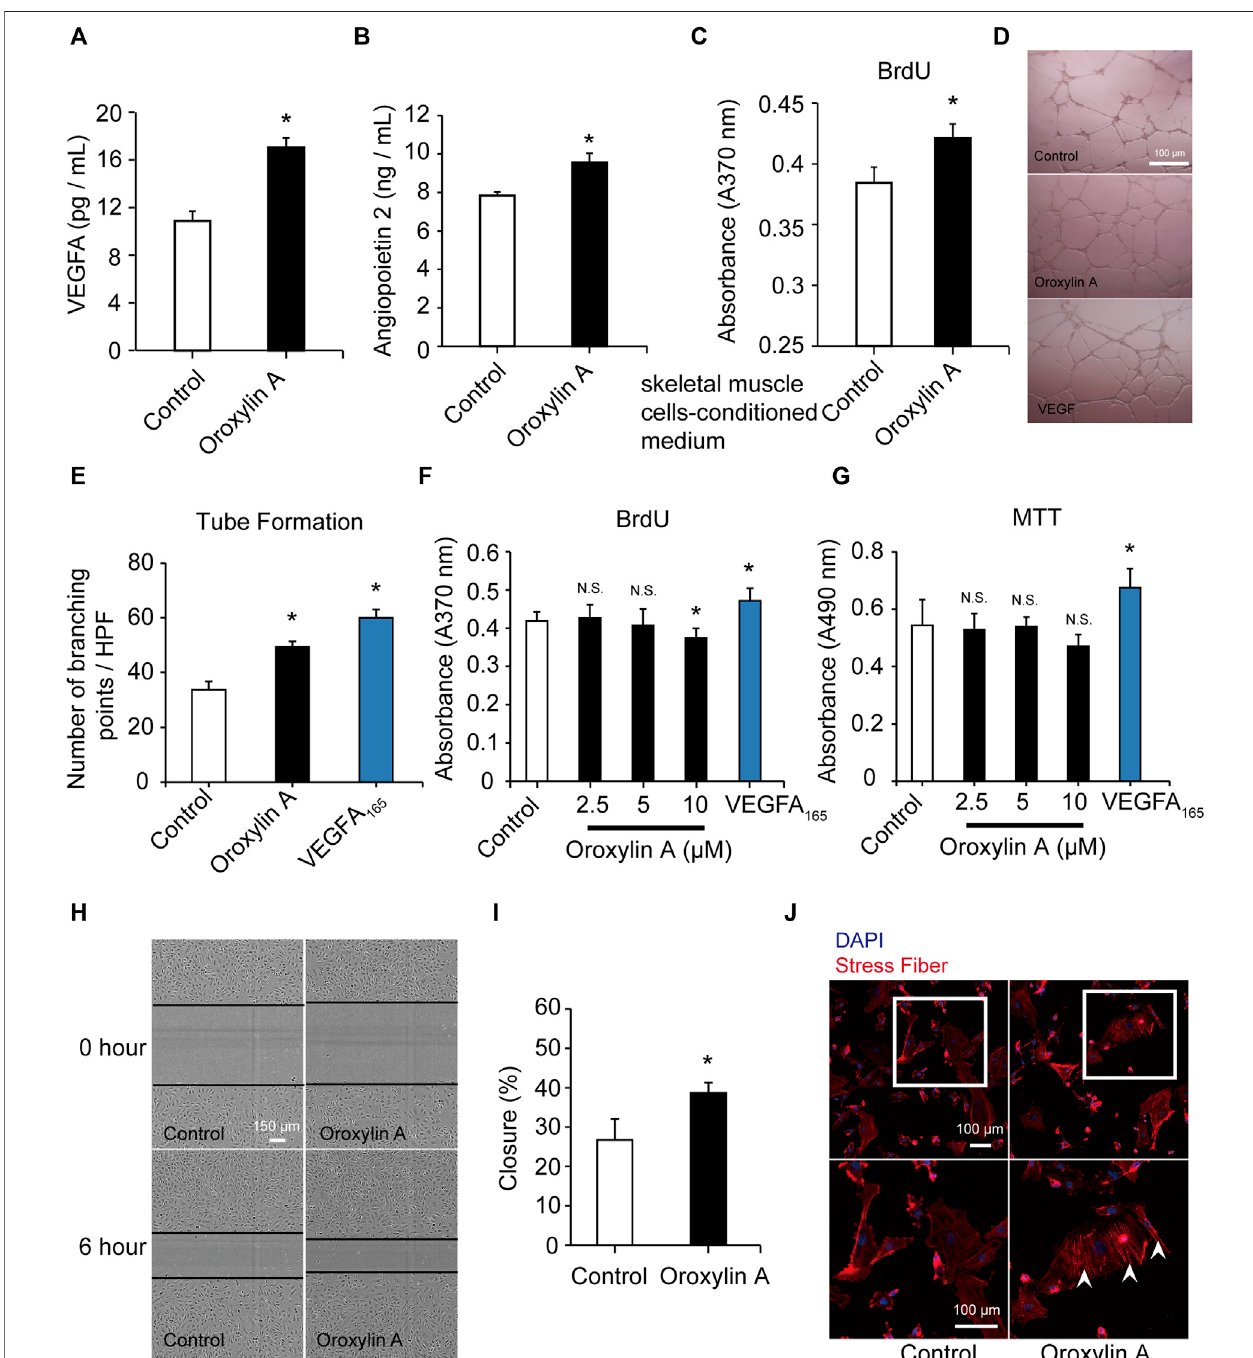
FIGURE 3 | OA promoted the secretion of VEGFA and ANG-2 in skeletal muscle cells and induced tube formation and migration in HUVECs. Skeletal muscle cells were cultured with DMSO or OA (2.5 µM) for 24 h, and then the contents of VEGFA (A) and ANG-2 (B) in the supernatant were quanti fi ed by ELISA. After DMSO or OA treatment,mediumderivedfromskeletalmusclecellswasaddedtoHUVECinculturefor24 h,andthenassayedbyaBrdUkit (C) .Datawererepresentedasmean ± SD ( n (cid:2) 6). Tube formation of HUVECs were performed on Matrigelin responseto DMSO, OA (2.5 μ M) or VEGFA 165 for 18 h, with VEGFA 165 asa positive control. The scale bars represented 100 μ m (D) . Quanti fi cation of tube formation were presented as several branching points (E) . HUVECs were cultured with DMSO or OA (2.5, 5, 10 µM) for 24 h, and then assayed by a BrdU kit (F) and MTT assay (G) . VEGFA 165 was acted as a positive control. Representative images and quanti fi cation of ECs migration following scrape injury in responseto DMSO or OA (2.5 μ M) were shown in H and I . The scale bars represented 150 μ m. Actin cytoskeleton rearrangement in HUVECswasshown in (J) .Below isahigher magni fi cation ofthewhite-boxed area.Formationofstress fi bers terminatedat pointed edges(white arrowhead).The scale bars represented 100 μ m. Data were represented as mean ± SD ( n (cid:2) 5). * p < 0.05, N.S. not signi fi cant, vs. control.